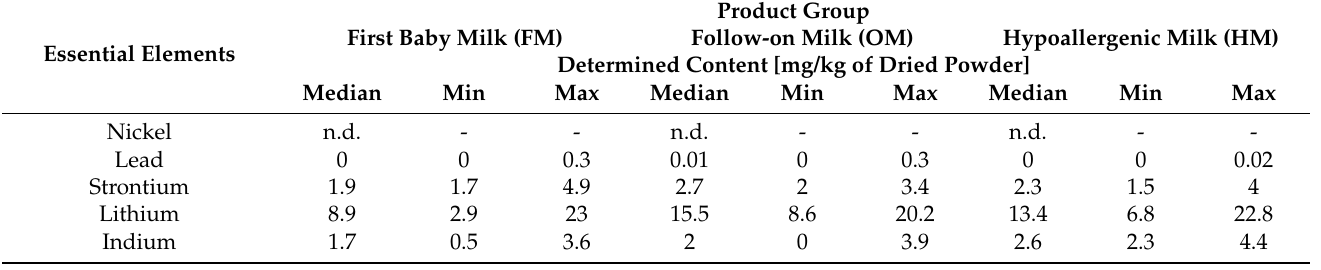
Table 4. The toxic elements content in analyzed baby milk (mg/kg of dried powder).